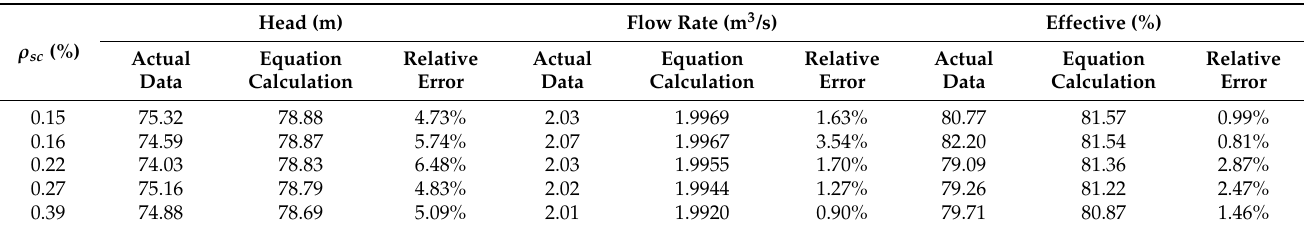
Table 6. Errors between actual data and calculated values of fitting